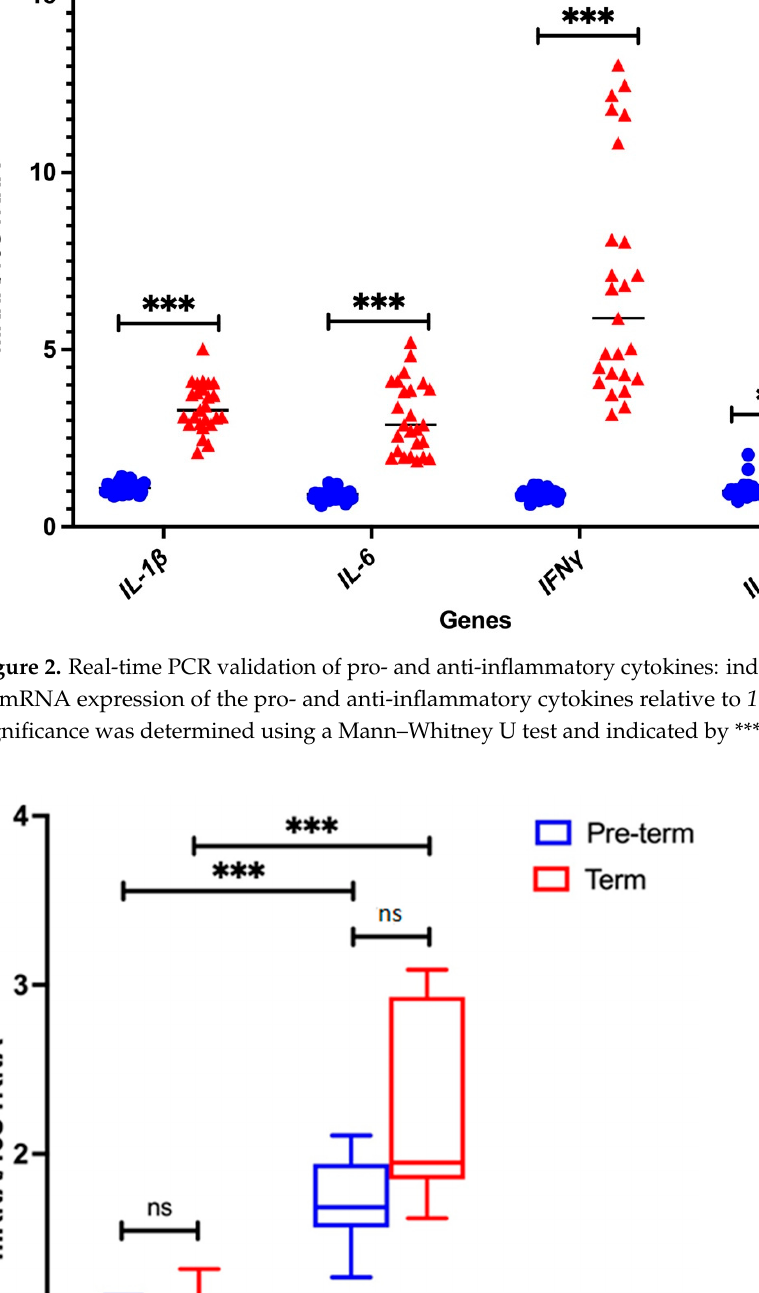
Figure 1. Real-time PCR validation of DAMPs: independent validation of DAMPs-involved mRNA gene expression relative to 18S rRNA . Statistical significance was determined using a Mann–Whitney U test and indicated by *** ( p < 0.001).